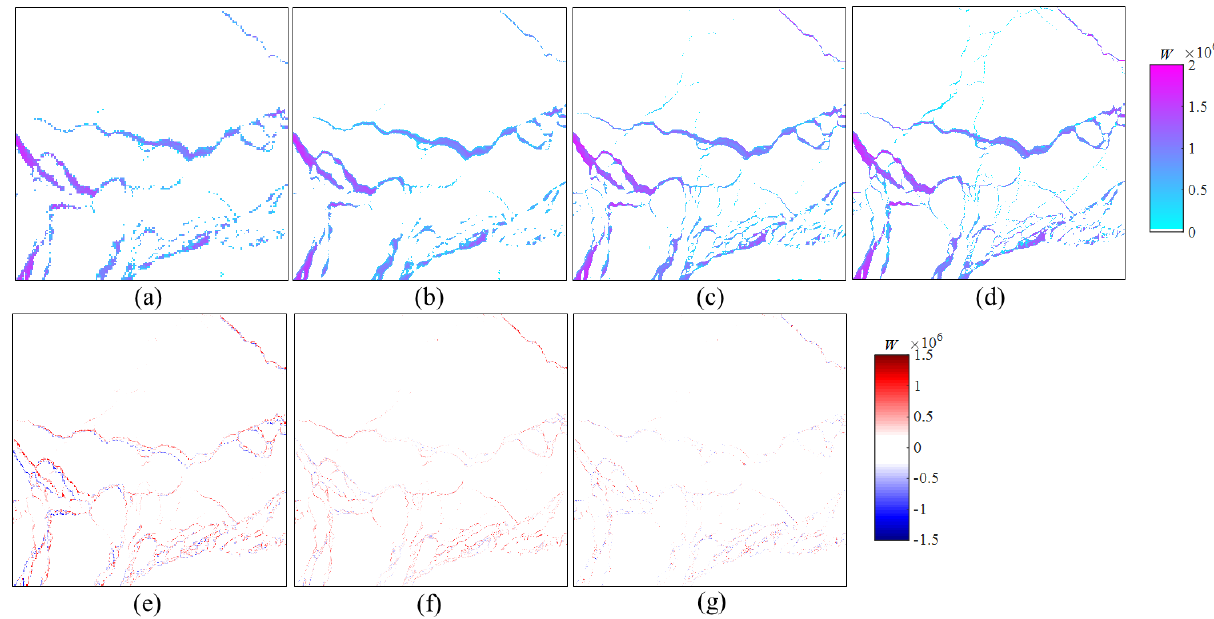
Figure 9. Spatial distribution of the THF calculated by different methods: (a) the OriTHF method; (b) the CubicSTHF method; (c) the proposed DeepSTHF method; (d) the reference distribution. The error maps of the distribution of the THF of (e) the OriTHF method, (f) the CubicSTHF method, and (g) the proposed DeepSTHF method.